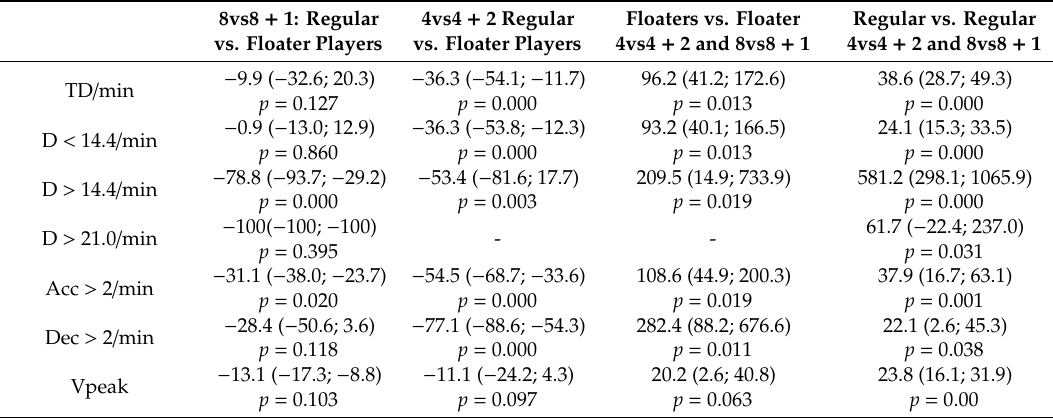
Table 4. Comparisons among floater and regular players in the physical demands during the 8vs8 + 1 LSG and the 4vs4 + 2